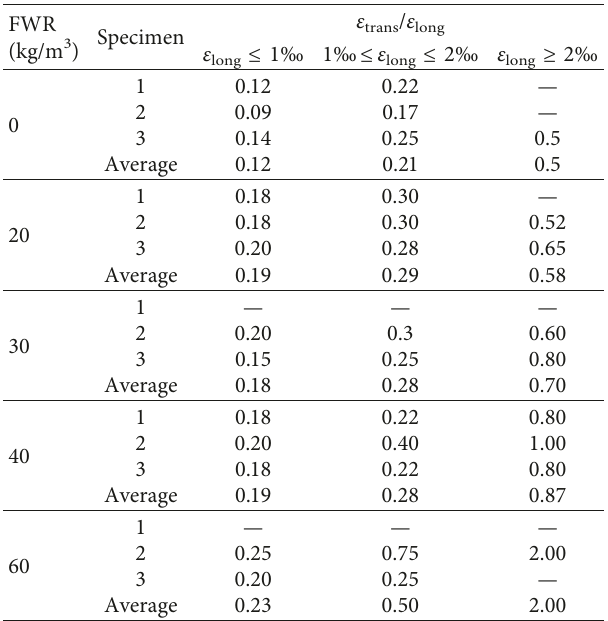
Figure 7: Proposed theoretical relationship between longitudinal deformations and transverse to longitudinal deformations’ ratio: A, linear behavior of HSC; B, nonlinear behavior of HSC; C, stage before the HSC reaches the ULS. Table 5: The ratio between transverse and longitudinal de- formations ( ε trans / ε long ) vs. the longitudinal ones ( ε long ).